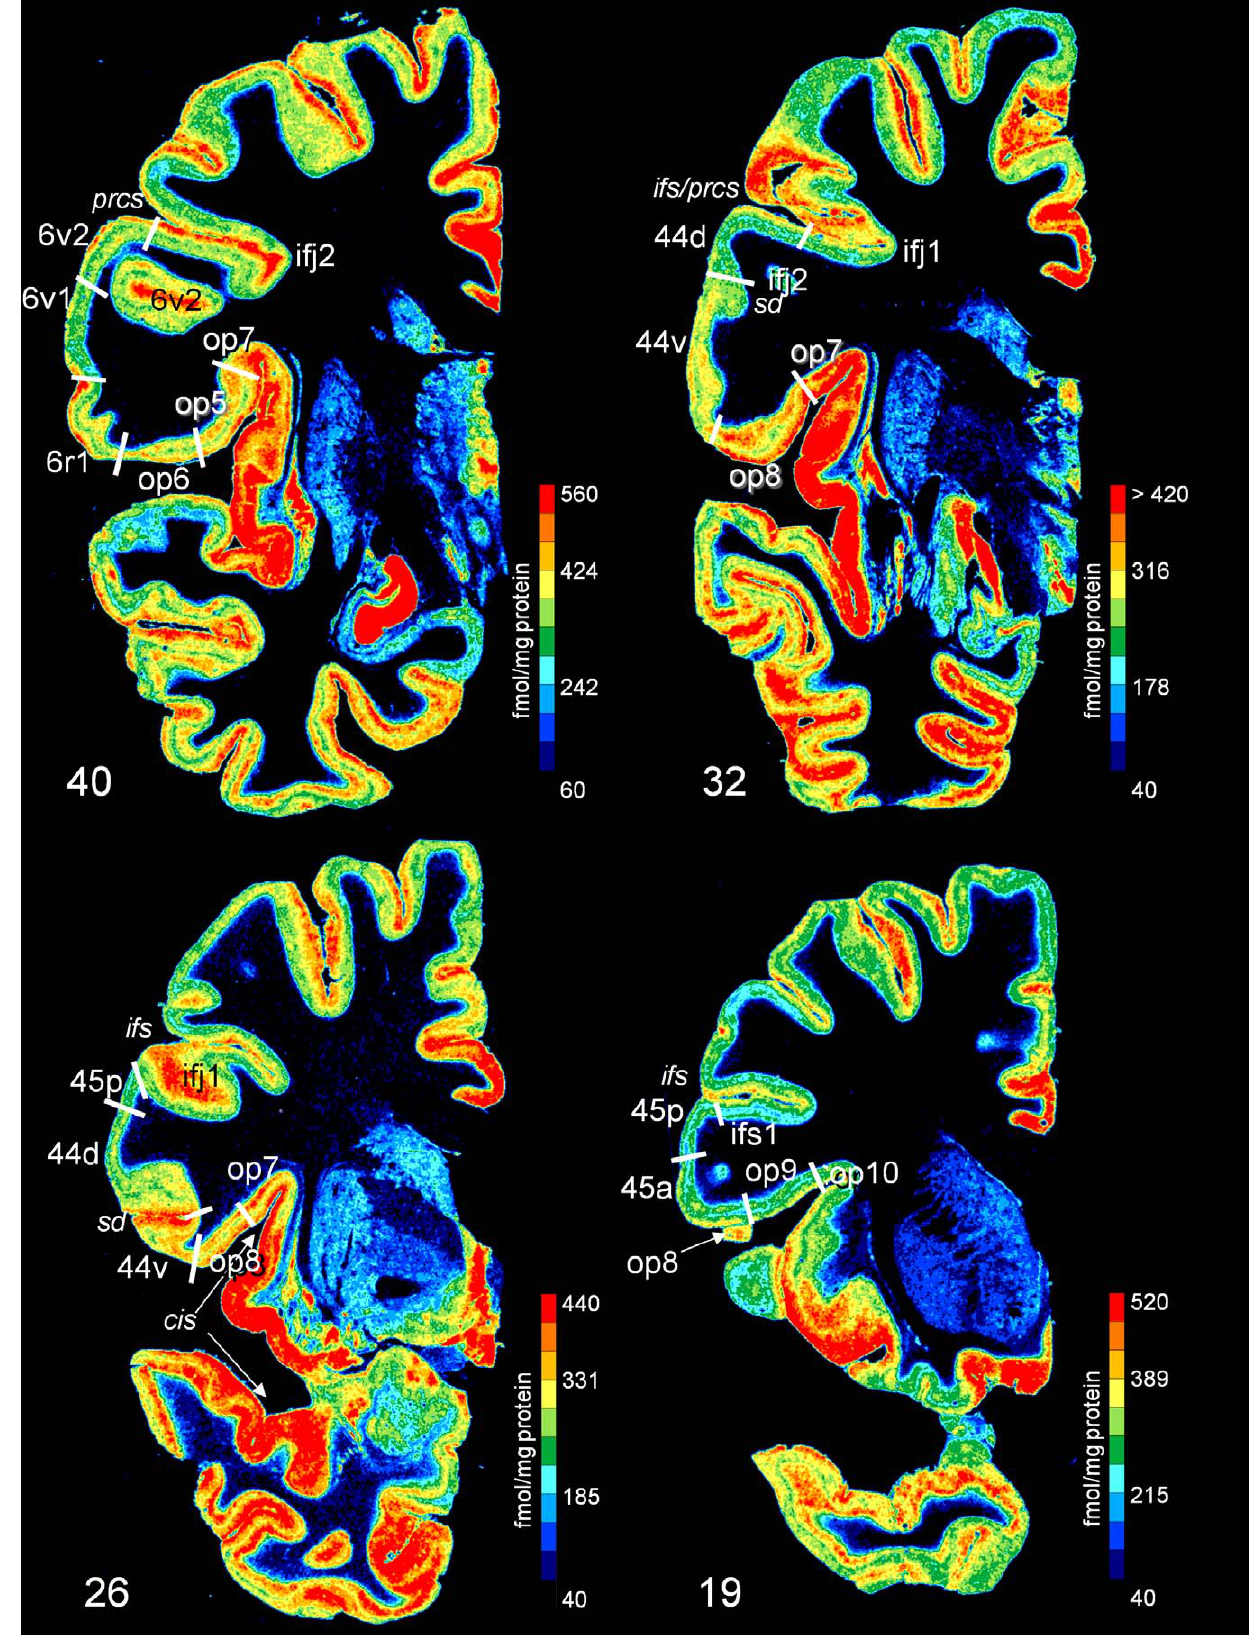
Figure 8. Topographical relationship of receptorarchitectonic areas in a series of four coronal sections (noradrenergic a 1 receptor, from caudaltorostralatlevels40,32, 26,and19. Thereceptorconcentrations are indicatedinfmol/mgproteinandcolor codedaccording tothecolorbaron the right of each section. Designation as above. doi:10.1371/journal.pbio.1000489.g008 PLoS Biology |